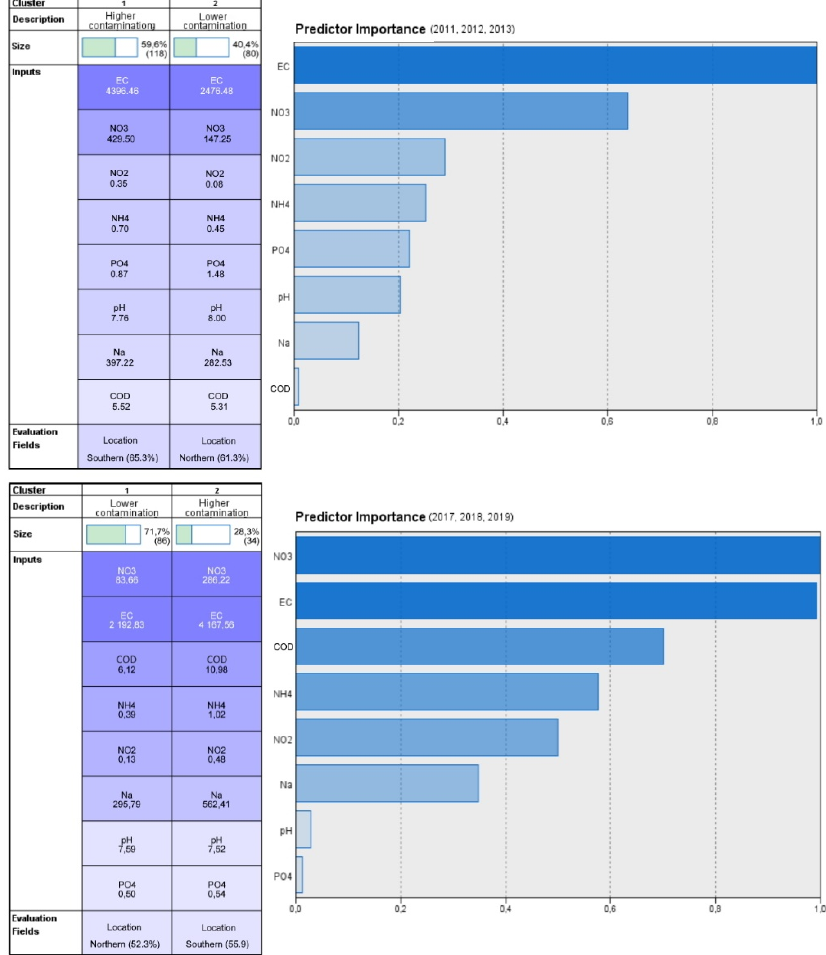
Figure 6. Results of two-step cluster analysis for data before and after the establishment of the sewerage network .